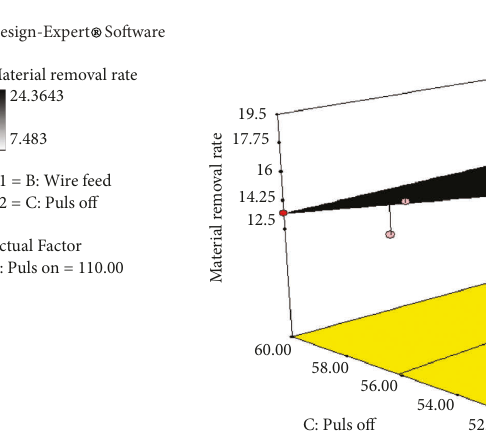
Figure 11: Effect on the PT